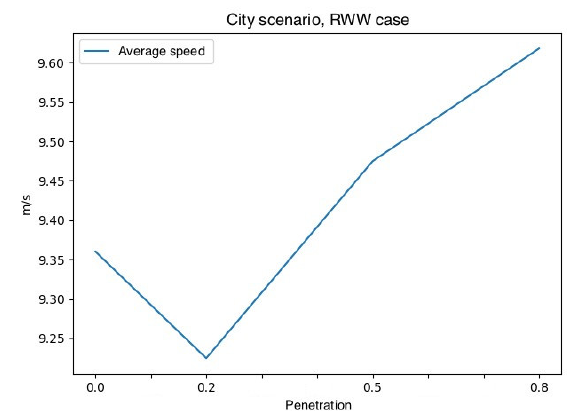
Figure 11. The average speed on a highway with RWW